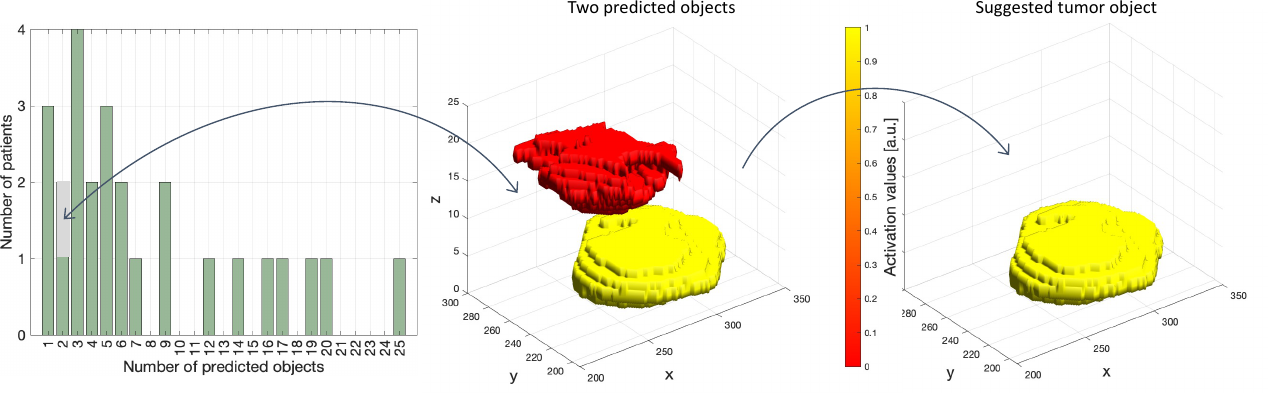
Figure 4. ( Left ): Histogram depicting number of objects in the prediction maps for the test cohort ( n = 26) using a sigmoid-transformed activation map with a threshold of 0.5. In only 3/26 patients a single object was identified, whereas in 23/26 patients multiple mask objects were suggested. ( Middle ): Surface rendering depicting two objects (in red and yellow) in one of the patients having two predicted objects (grey box in histogram). The surface colors red/yellow indicate corresponding low/high mean activation values for the two objects (a.u. = arbitrarily units). ( Right ): In this patient with two suggested objects, the yellow mask with highest mean activation value was automatically selected as primary tumor.